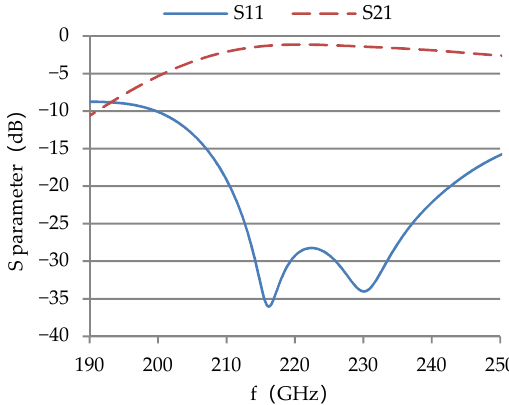
Figure 13. Measured S11 and S21 of a typical RF window employed in the TWT.